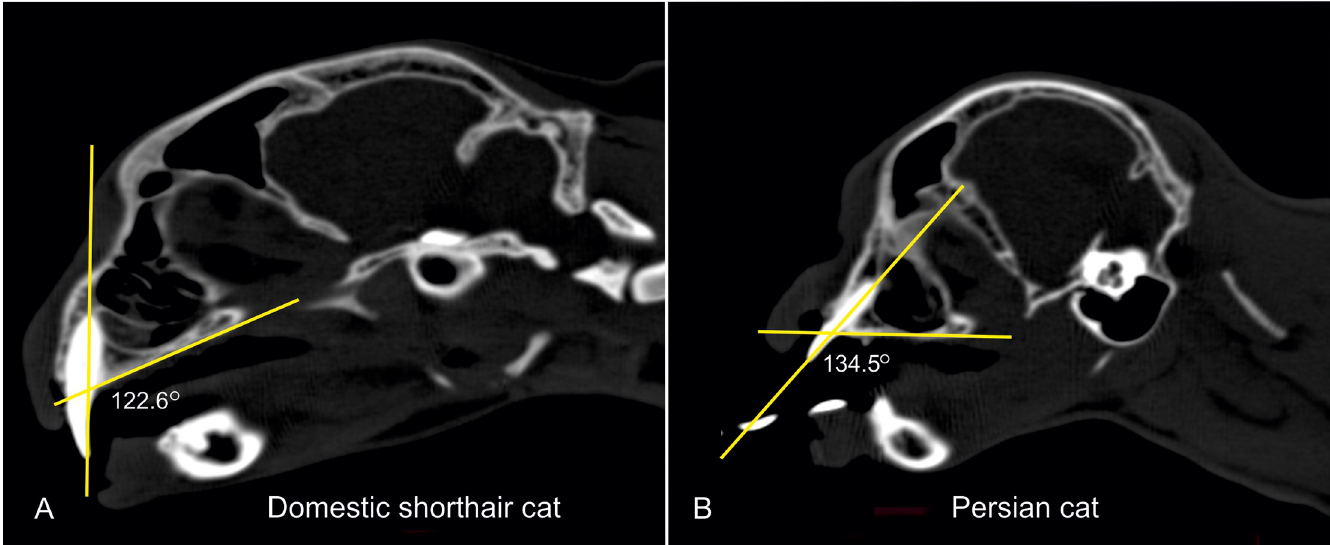
Fig 7. Measurement of the angle between the canine tooth and the hard palate. Two-dimensional CT images in a sagittal plane of an less severebrachycephalic Persian (A) and an extreme brachycephalic Persian (B) demonstrating the measurement of the angle between the canine tooth and hard palate. Axis (1) passes through the dental root and the dental crown. Axis (2) runs along the most cranial and caudal points of the hard palate. Both axes are coloured yellow. Ventrally, between the two axes, the angle is measured in